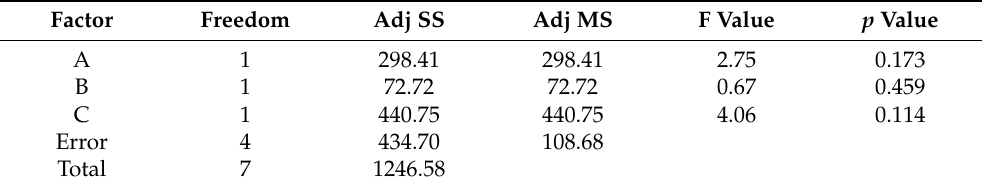
Table 6. Variance